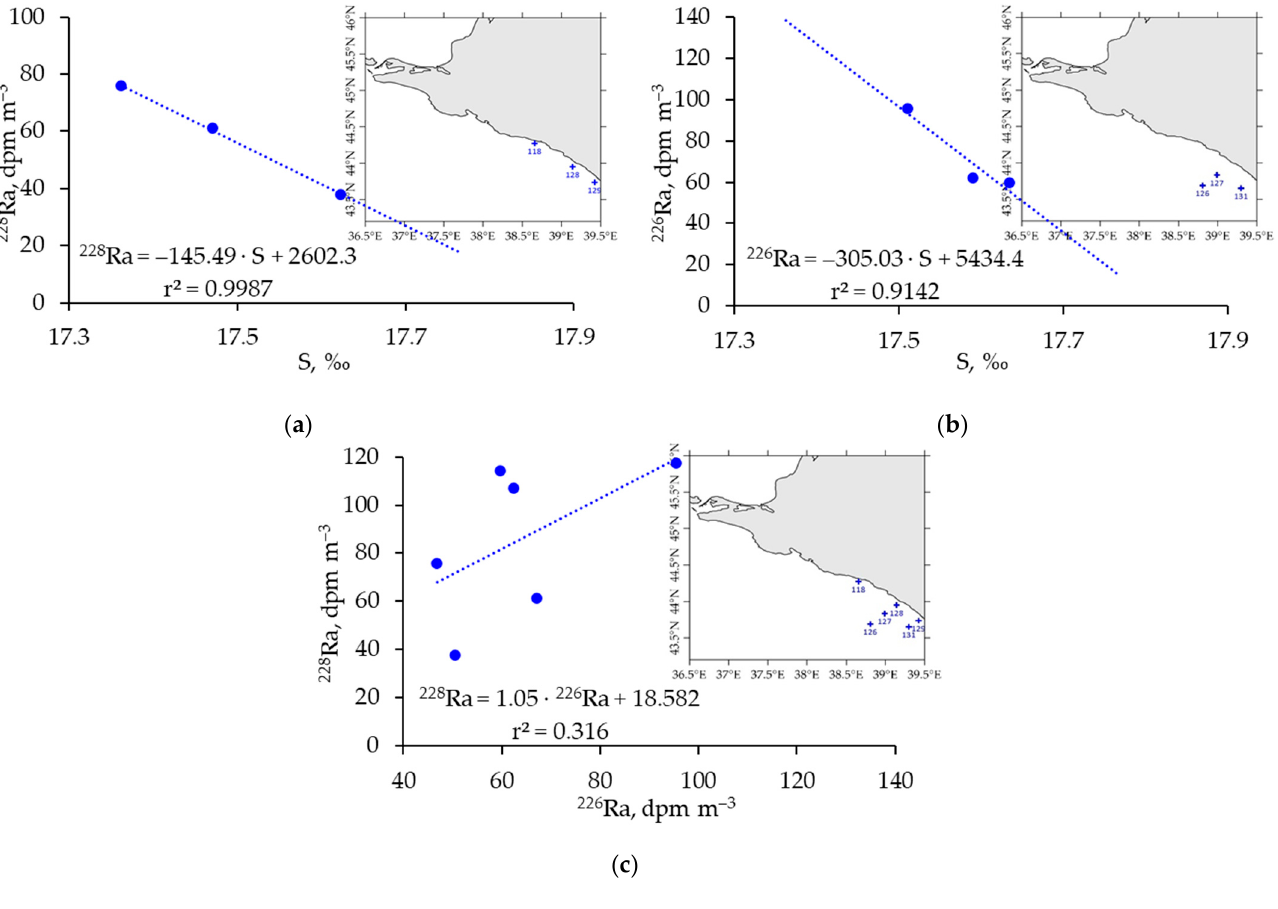
Figure 7. 228 Ra/ 226 Ra ratio in the 116 cruise study area in comparison with the submarine groundwa- ter source region near Cape Ayia.